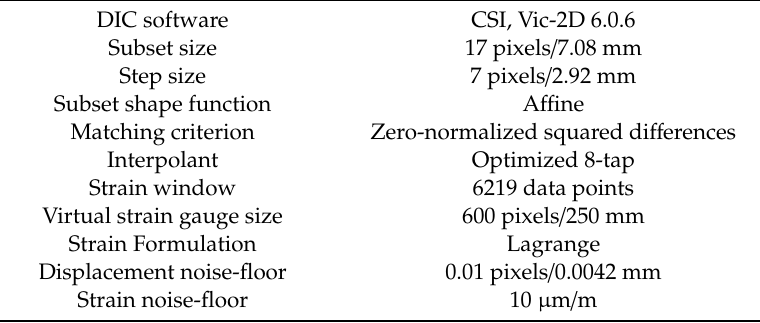
Table 2. DIC analysis parameters.